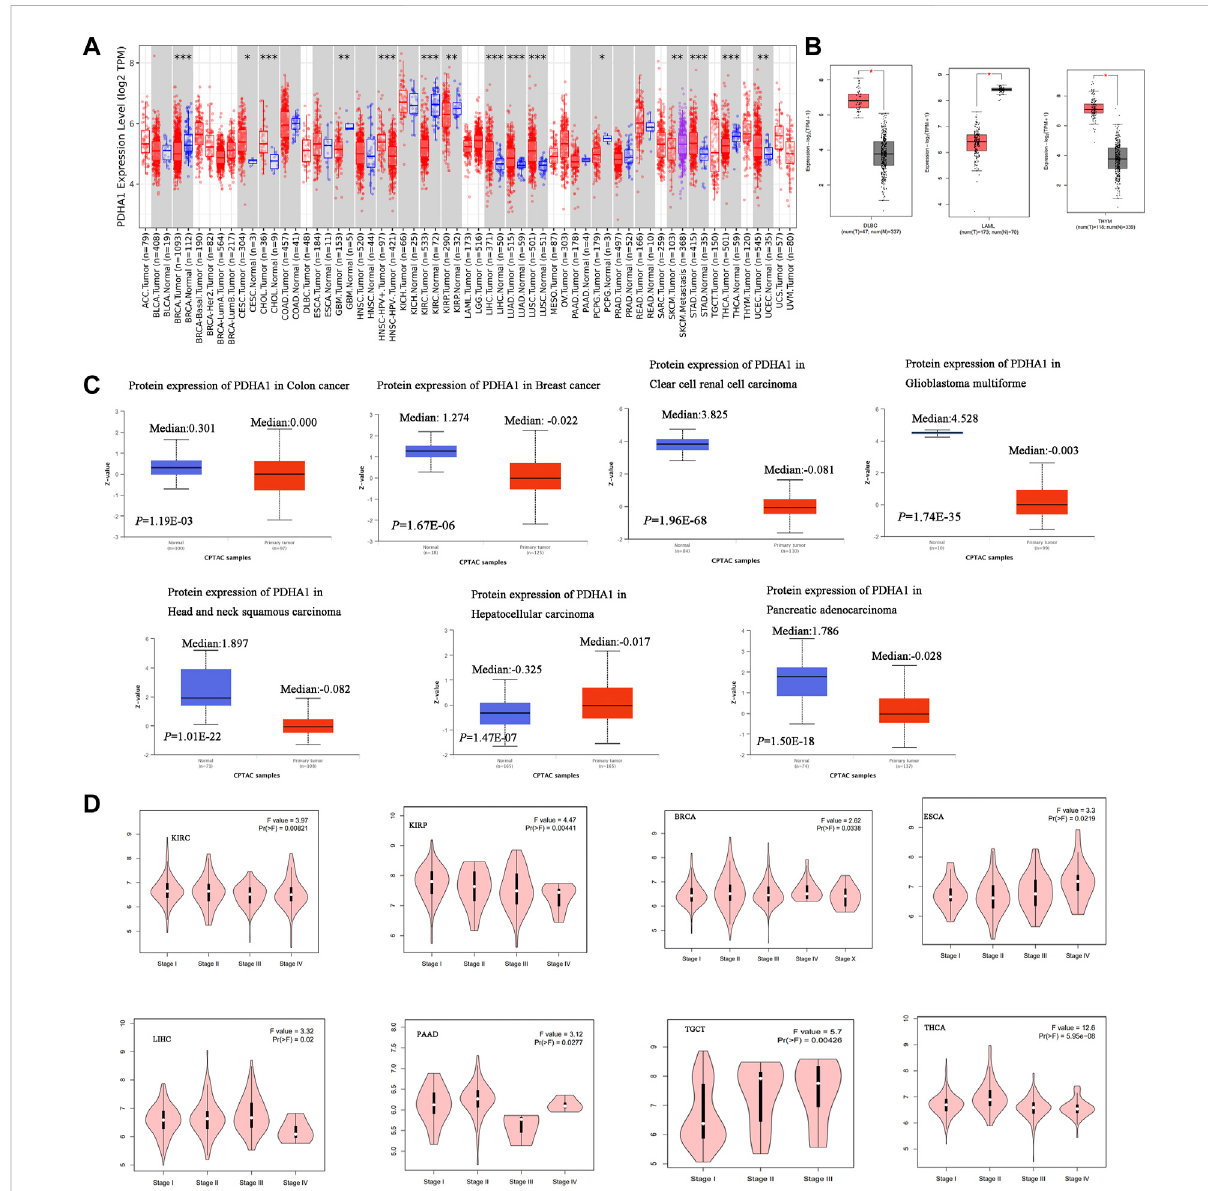
FIGURE 1 AberrantexpressionofPDHA1inpan-cancer. (A) mRNAlevelofPDHA1performedbytheTIMER2database. (B) BoxplotofPDHA1mRNAlevelin DLBC, LAML, and THYM performed by the GEPIA2 database. (C) Total protein level of PDHA1 in normal tissue and COAD, BRCA, KIRC, GBM, HNSC, PAAD, and LIHC performed by CPTAC. (D) Relationship between PDHA1 expression and tumor pathological stage performed in GEPIA2. * p < 0.05; ** p < 0.01; *** p <